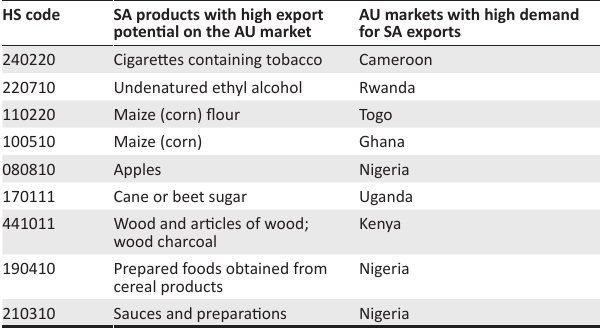
TABLE 4: South African products with the highest export potential. HS code